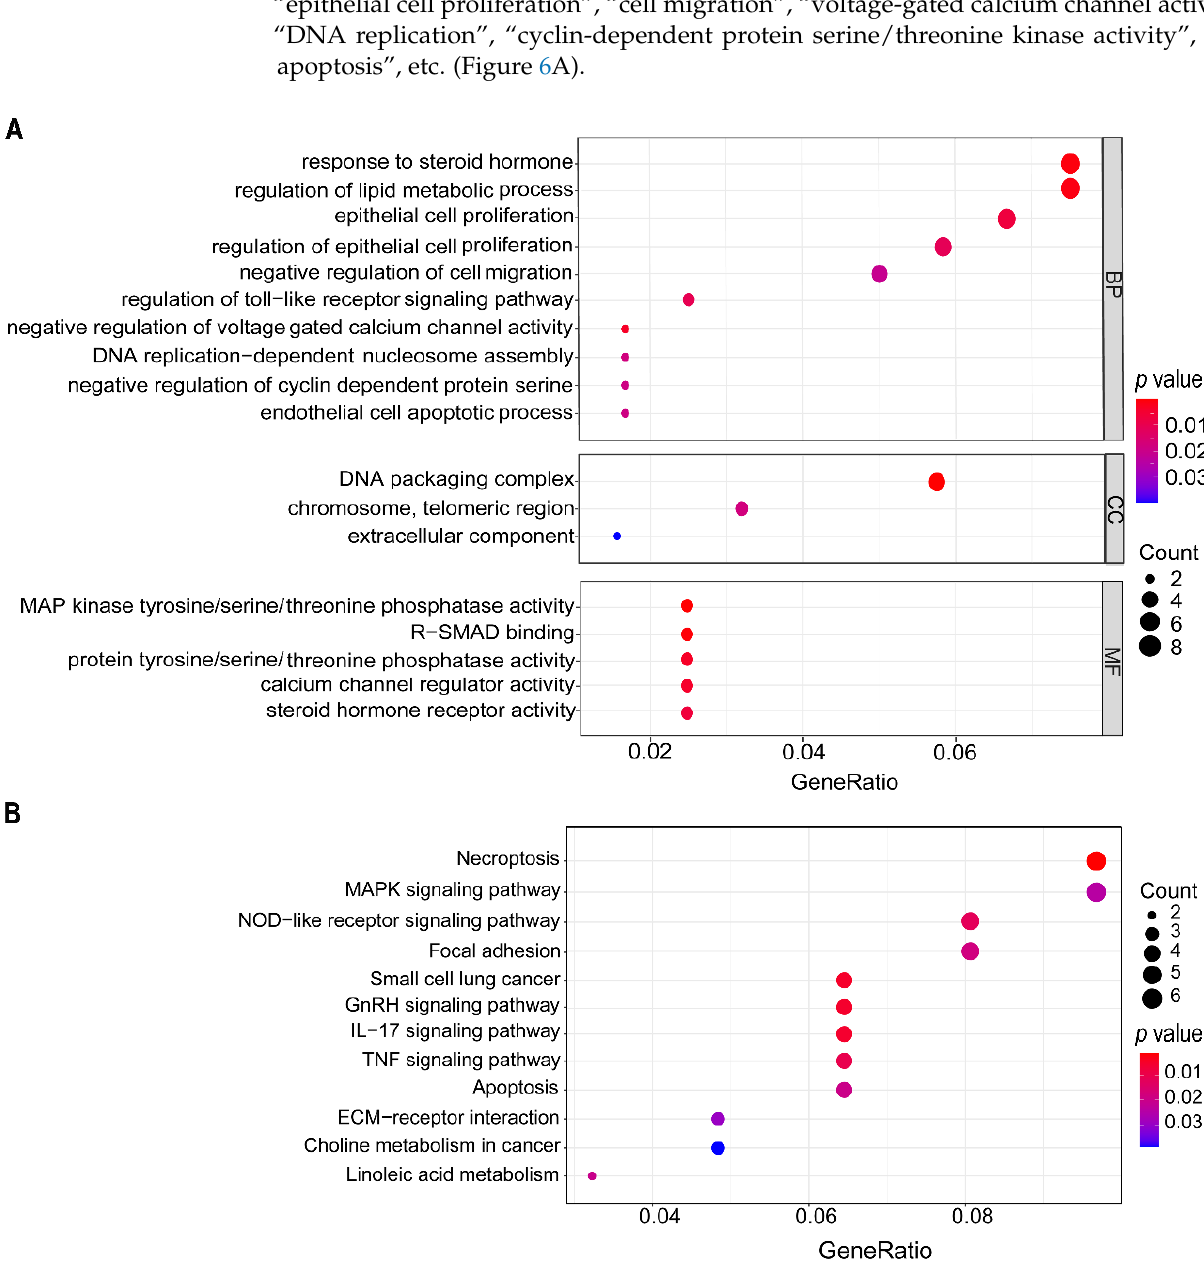
Figure 6. Analysis of gene functions for deslanoside-induced DEGs. ( A ) Bubble diagram of GO terms defined by DEGs in both cell lines. The vertical axis represents GO terms, and the horizontal axis represents the gene ratios indicating the enrichment degree. A larger gene ratio means a more robust enrichment. The size of a dot reflects the number of genes defining a GO term. ( B ) Signaling pathways enriched by DEGs, as revealed by the KEGG pathway enrichment analysis. The vertical axis indicates different pathways, and the horizontal axis indicates the gene ratio. A higher gene ratio, marked by a larger circle, means a more robust enrichment for a pathway. The size of dots is determined by the number of DEGs in a pathway. BP, biological process; CC, cellular component; MF, molecular